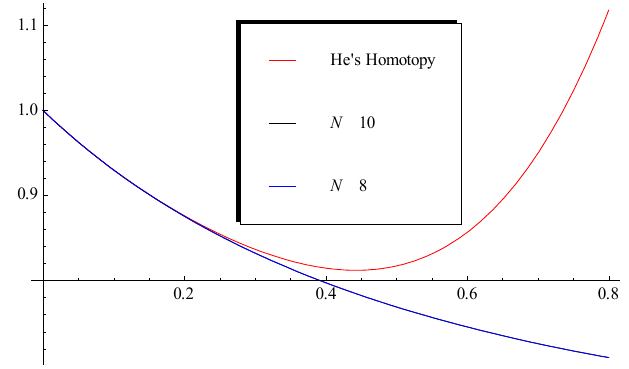
   v at different N with He’s Homotopy solution. Figure 5. Approximate solution v N ( τ ) at di ff erent N with He’s Homotopy solution. N